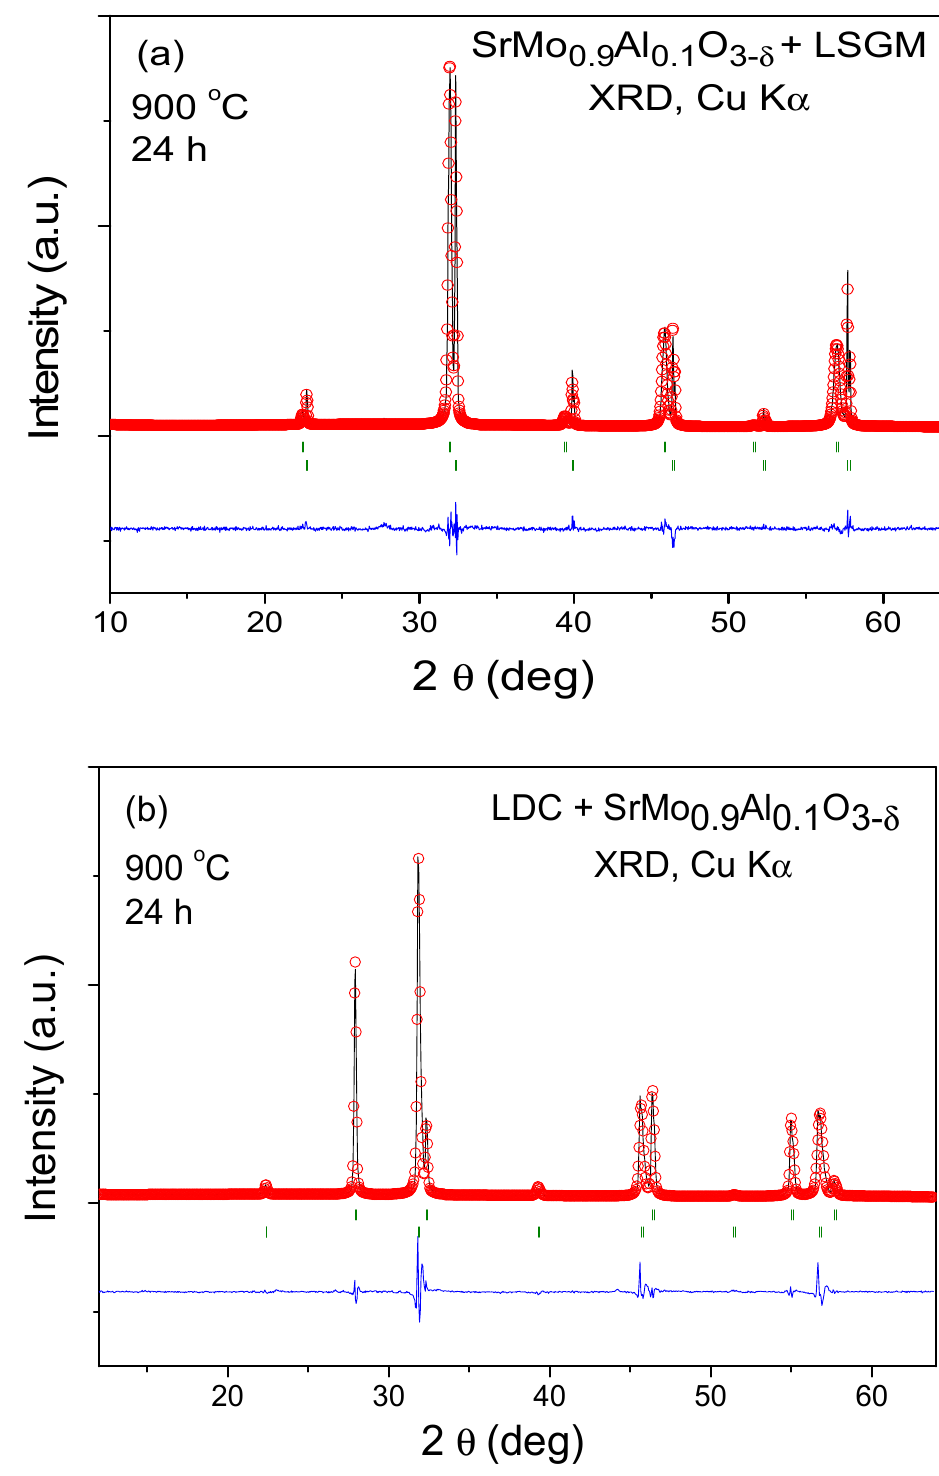
Figure 6. Rietveld-refined XRD profiles of a mixture of ( a ) SrMo 0.9 Al 0.1 O 3 − δ and LSGM and ( b ) LDC and SrMo 0.9 Al 0.1 O 3 − δ after a thermal treatment at 900 ◦ C in H 2 (5%)/N 2 , showing no reaction products between both phases other than the initial reactants. The first and second series of Bragg positions correspond to ( a ) SrMo 0.9 Al 0.1 O 3 − δ and LSGM and ( b ) LDC (with fluorite structure) and SrMo 0.9 Al 0.1 O 3 − δ , respectively.